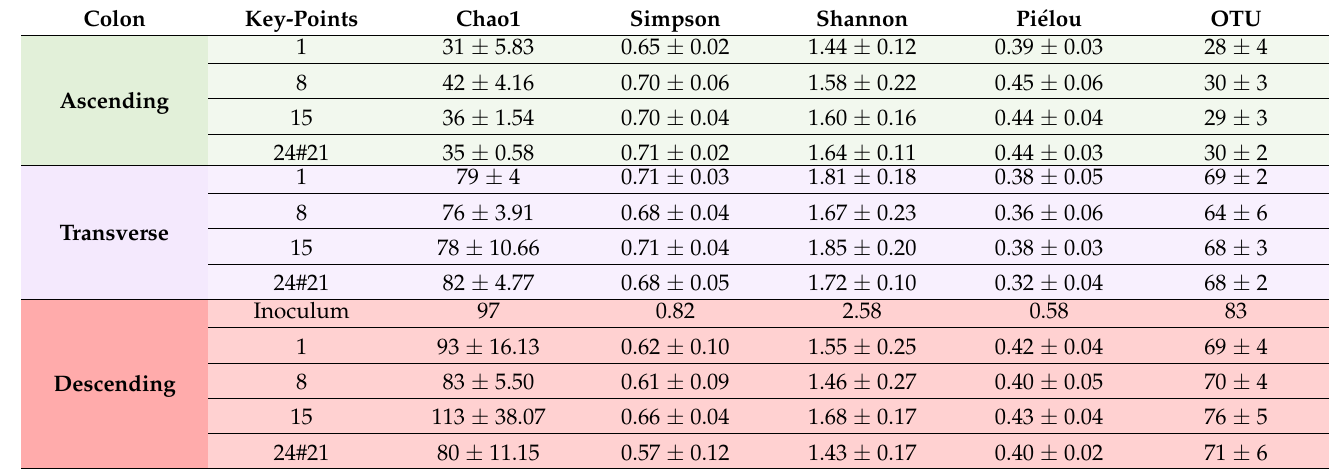
Table 2. The average of the Chao1 estimator, Simpson, Shannon, and Pi é lou index, and OUT number observed in the ascending, transverse and descending colons after one daily ULIP33 phage injection (10 mL at 10 9 PFU/mL) in the ascending colon for 7